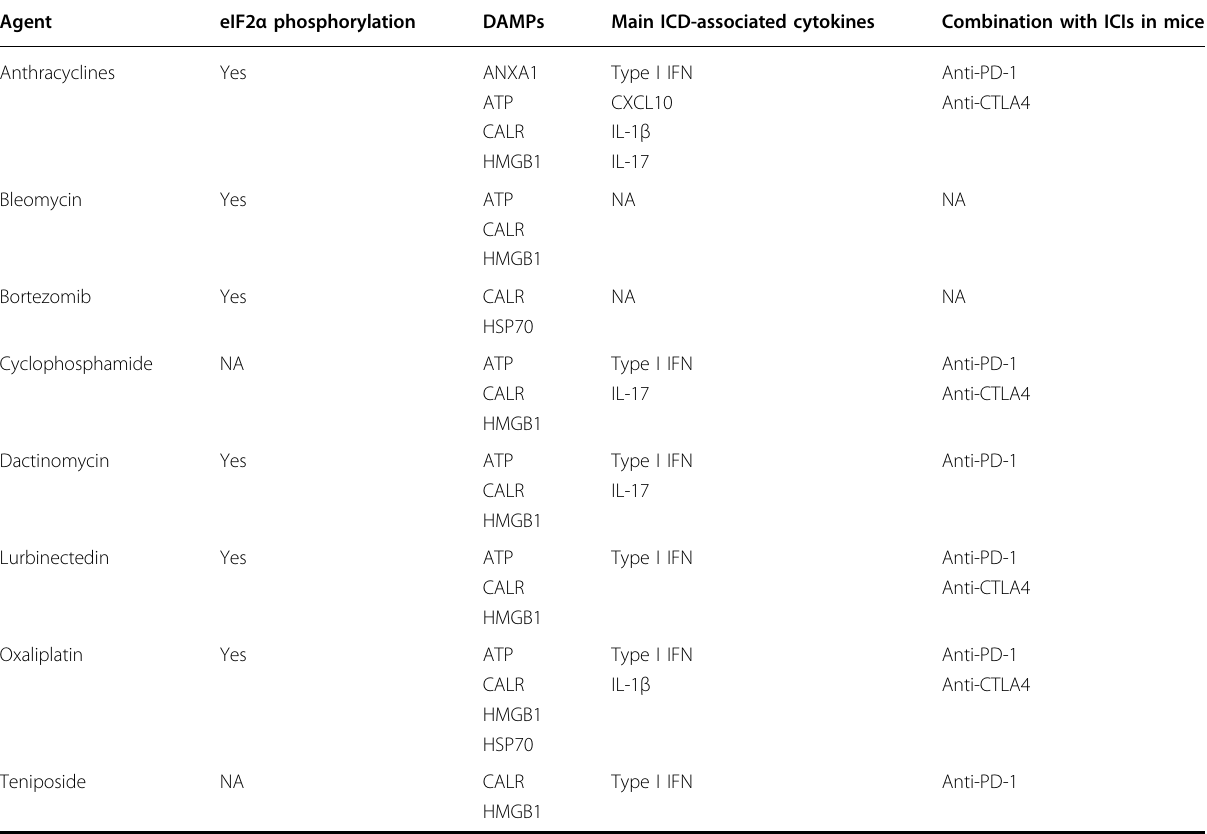
Table 1 Immunogenic cell death inducers commonly employed as conventional chemotherapeutics a